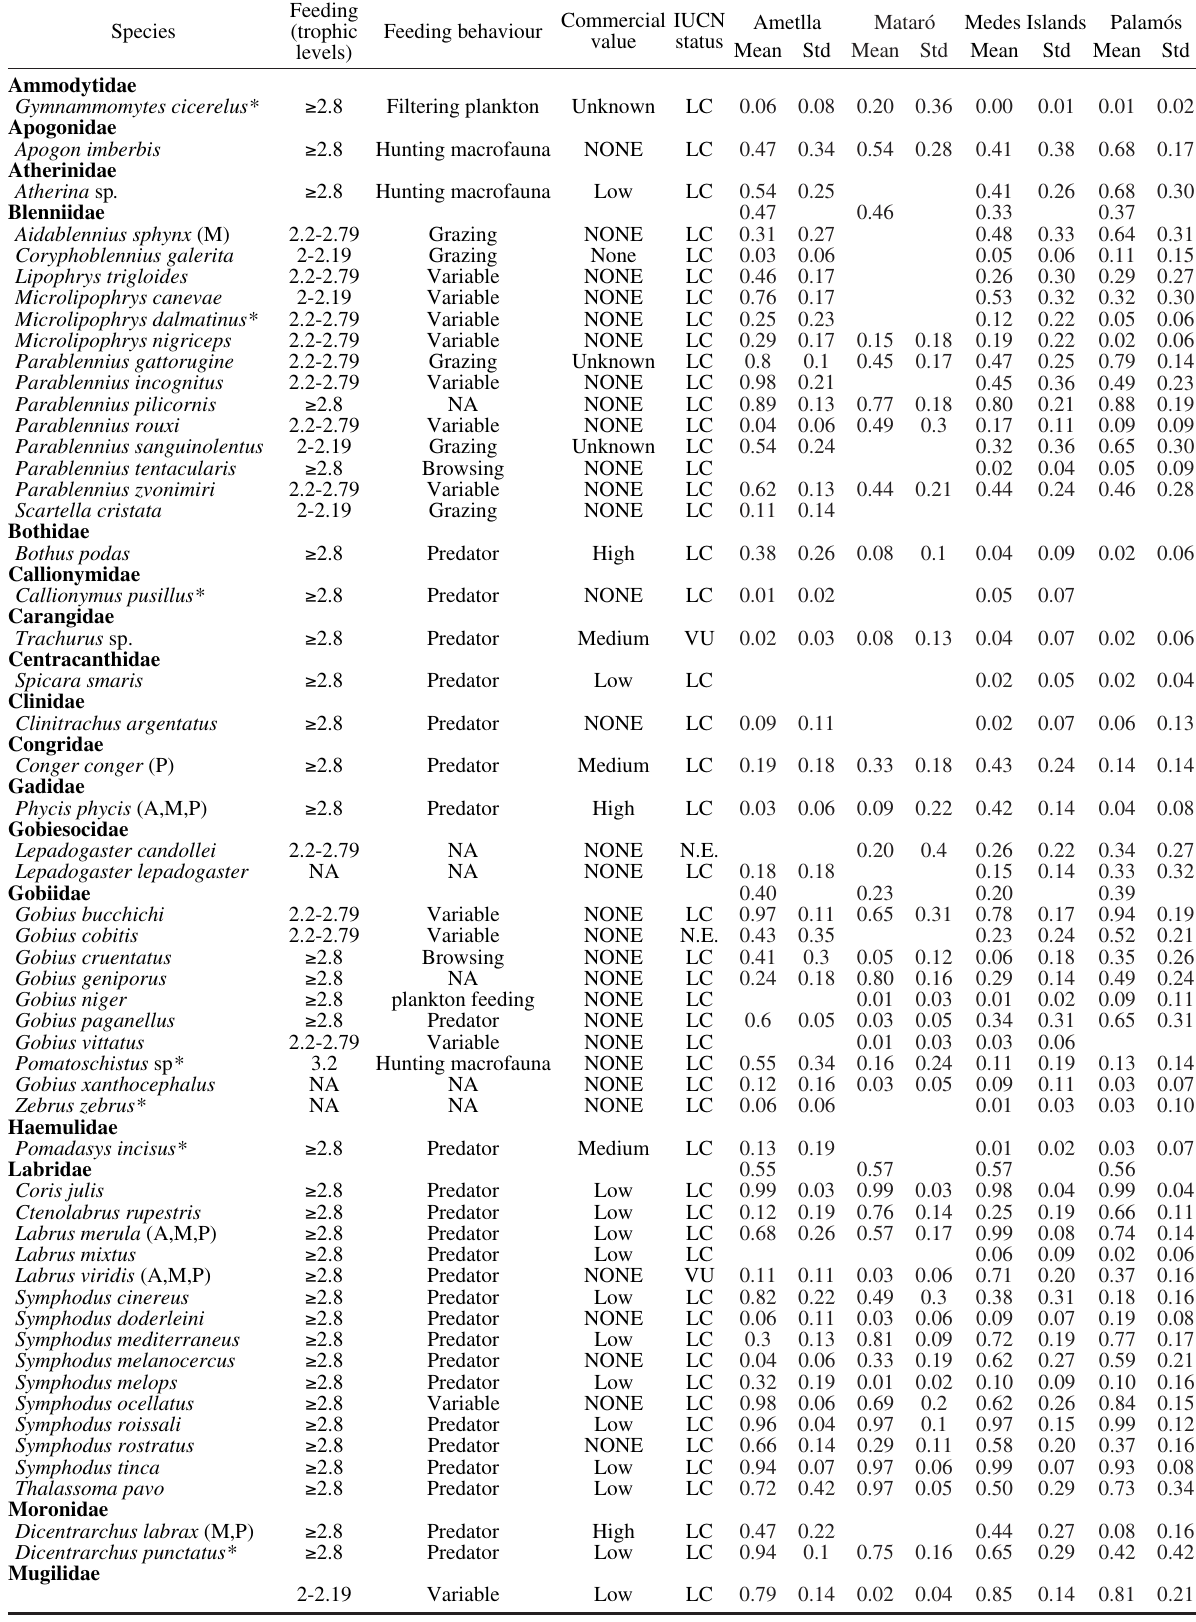
differences were observed. Asterisks indicate a species described for the first time in the